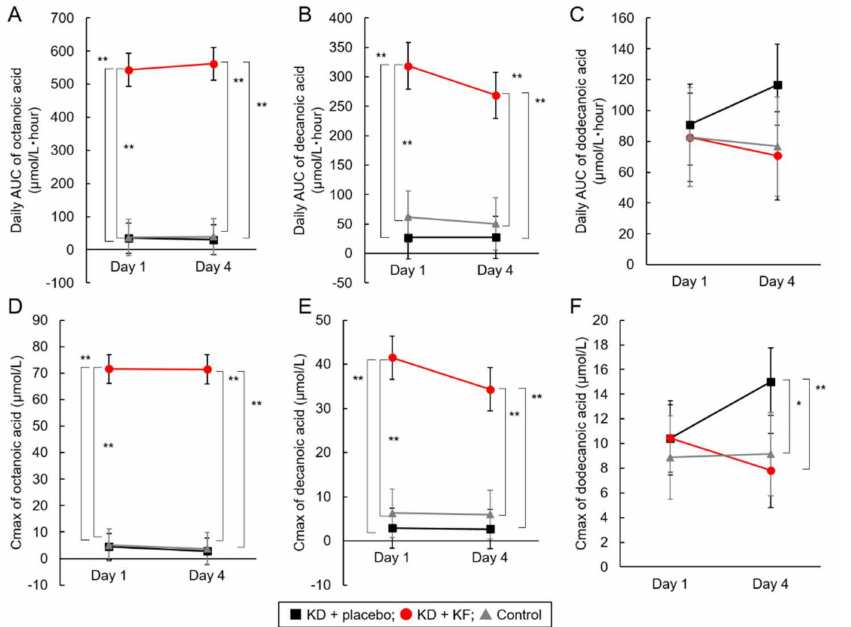
Figure 6. Analysis of the results of secondary endpoints. The daily AUC of plasma octanoic ( A ), de- canoic ( B ), dodecanoic ( C ) acid concentration; Cmax of plasma octanoic ( D ), decanoic ( E ), dodecanoic ( F ) acid concentration. *: p < 0.05, **: p < 0.01, Tukey–Kramer’s test.